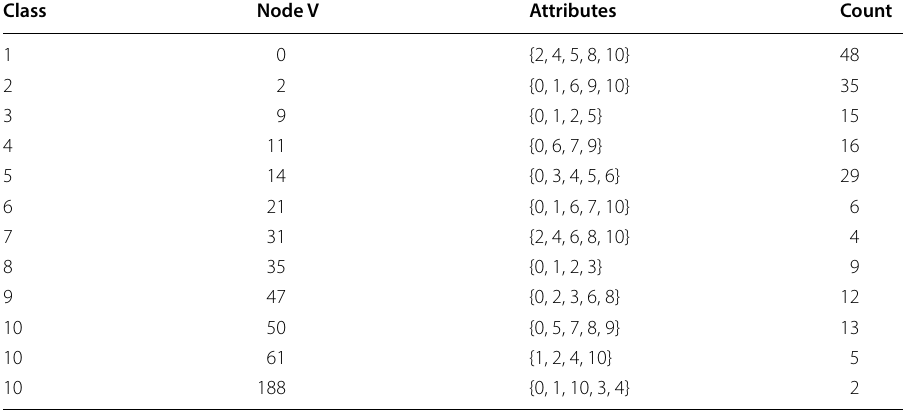
Table 13 Attribute Index Structure for Caesars-WiFi Dataset